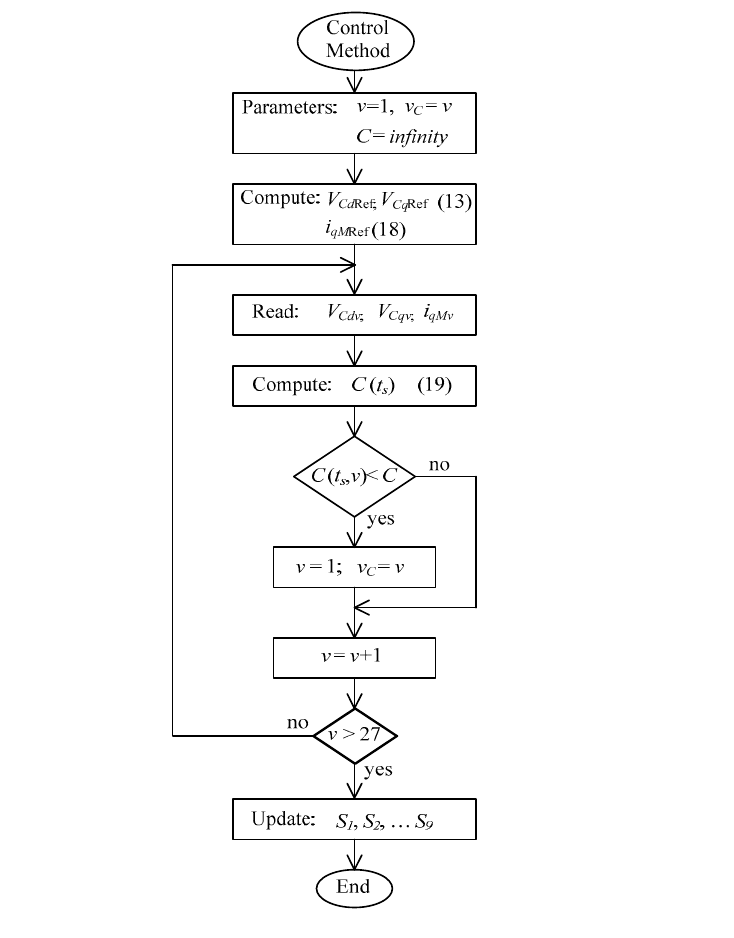
Figure 5. Flowchart of the control method proposed to compute V Cd Ref , V Cq Ref (13) and i qM Ref (18).